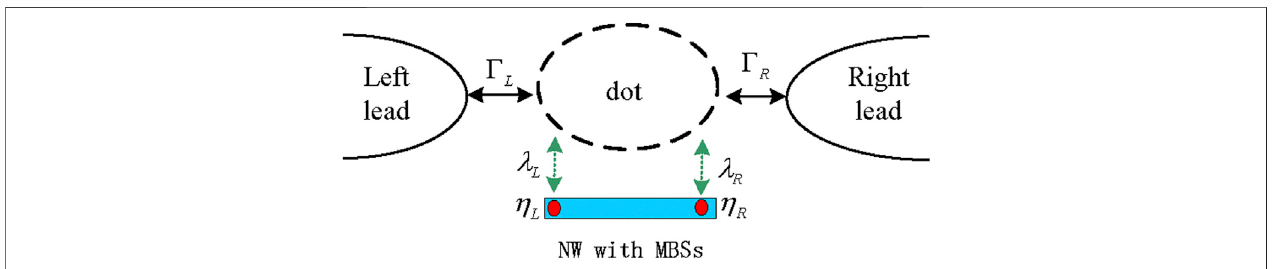
FIGURE1| PlotofaquantumdotconnectedtoMBSspreparedattheendsofatopologicalsuperconductornanowire.Thedotiscoupledtotheleftandrightleads and to a phonon bath with phonon frequency ω q .